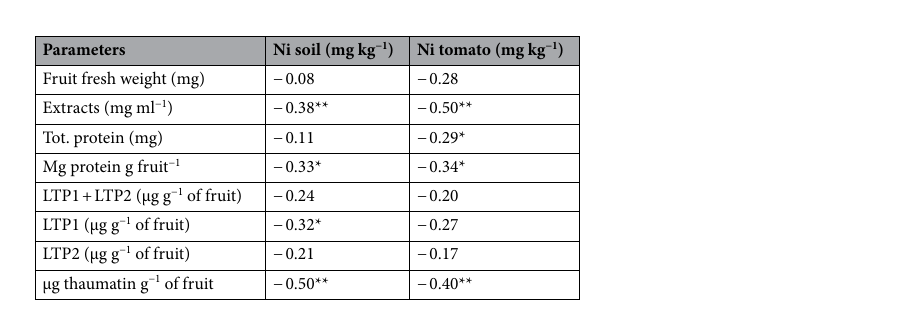
Table 7. Pearson’s correlations comparing Ni soil and Ni tomato with fruit biomass and proteins expressed. *Significant P < 0.05. **Highly significant P < 0.01.